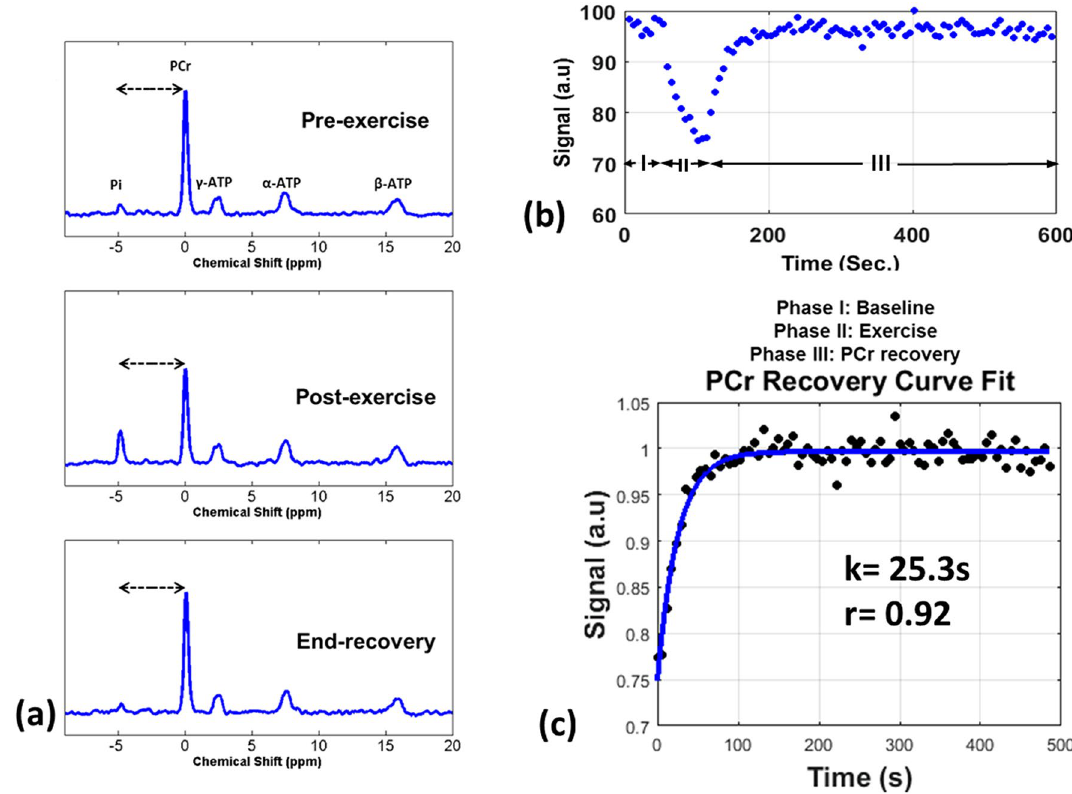
Figure 1. Dynamic 31 P-MRS results in healthy volunteer. ( a ) Shows 31 P-MR spectra from a representative healthy volunteer’s calf muscle pre-exercise, post-exercise, and at end-recovery. The dashed arrows indicate the distance between Pi and PCr peaks ( b ) shows the kinetics of PCr signal intensity during the three phases for the healthy volunteer and ( c ) shows the PCr recovery time constant (k = 25.3 s for this volunteer) after fitting the phase III PCr recovery